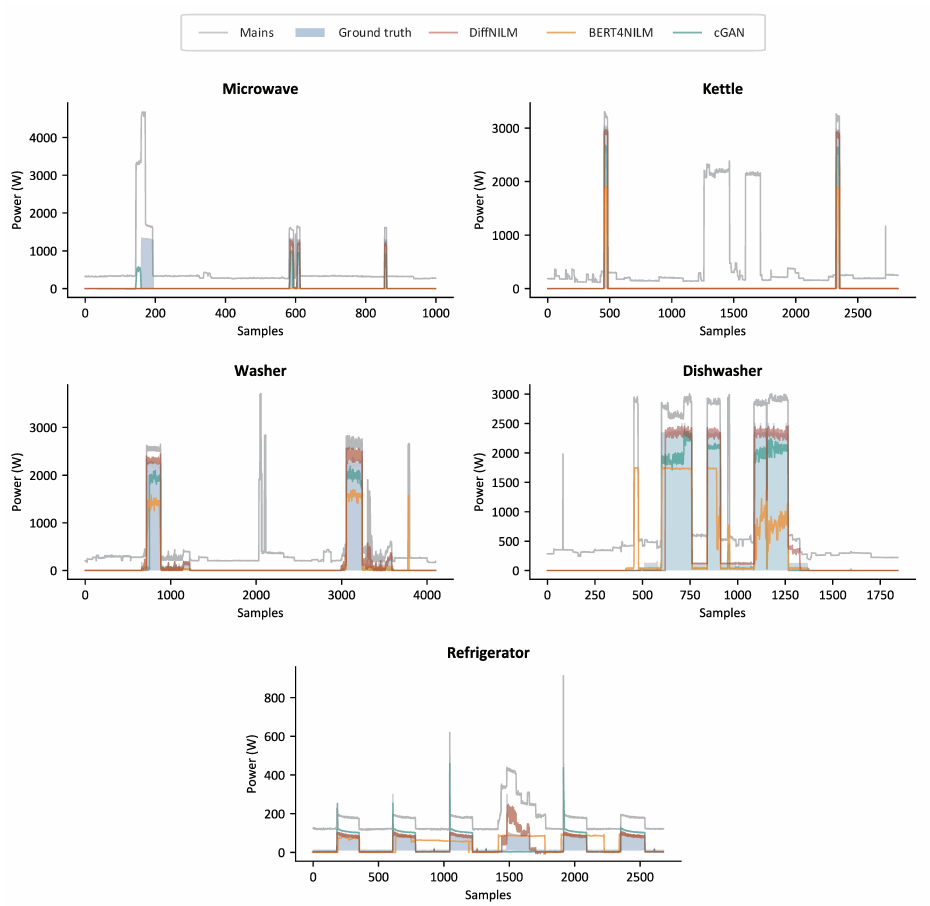
Figure 7. Sample outputs of microwave, Washer, dishwasher and refrigerator on REDD.